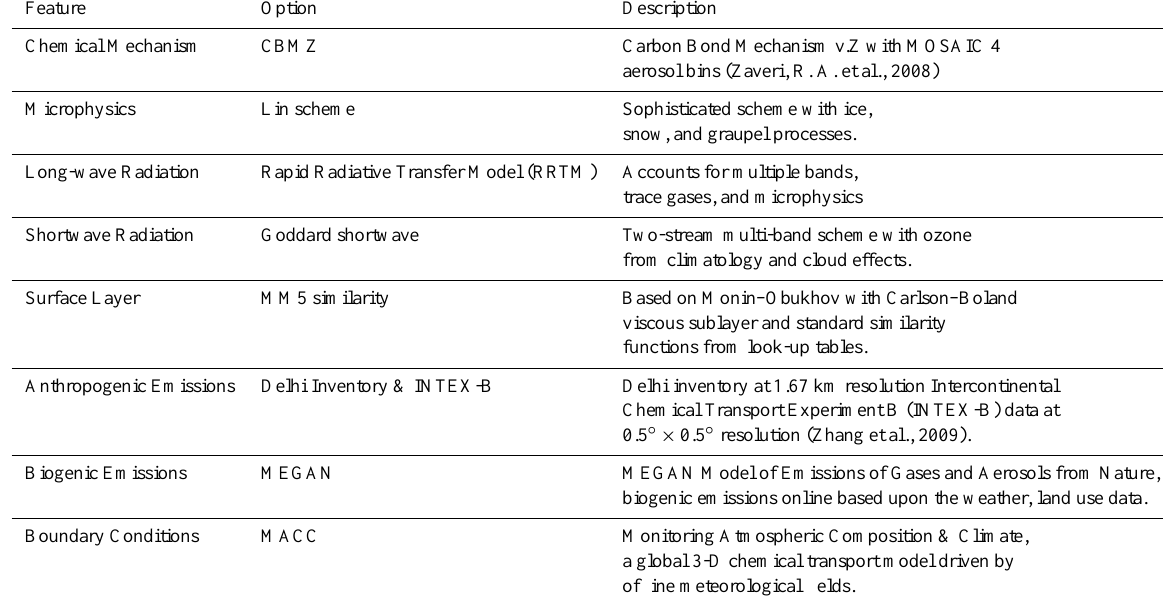
Table 1. Important input settings of the WRF-Chem model used in this study.